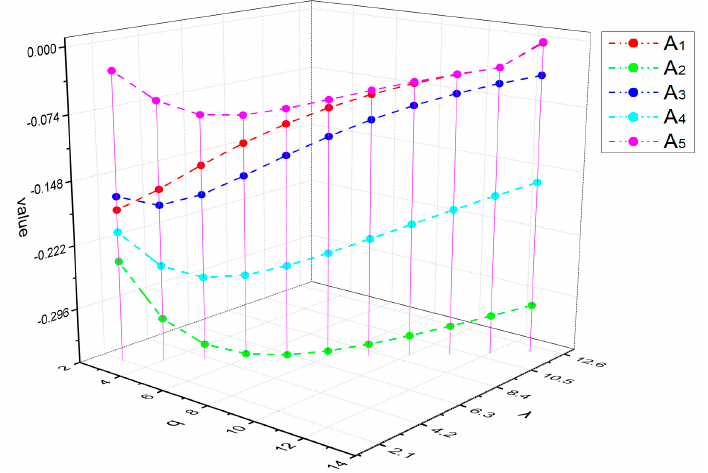
Figure 6. The influence of the simultaneous change of q value and λ in Gq-RONFHG operator on the sorting result.